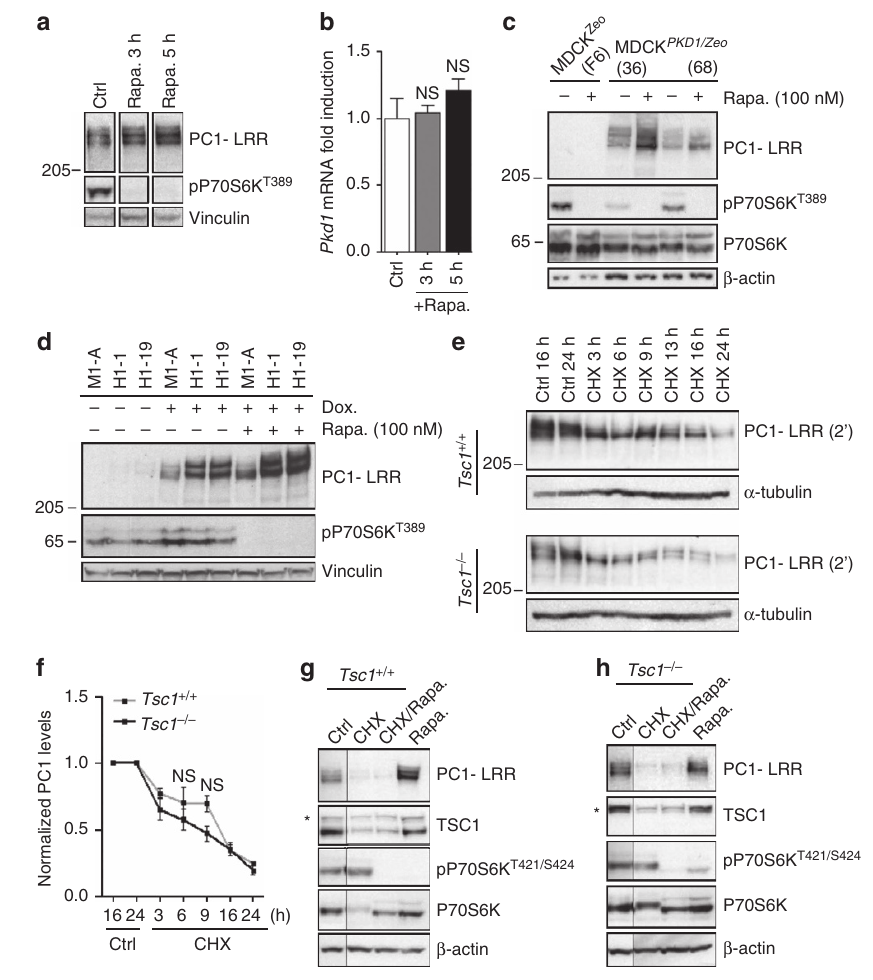
Figure 3 | mTORC1 regulation of polycystin-1 requires protein neo-synthesis. ( a ) Immunoblot shows increased PC1-LRR levels in Pkd1 Myc/Myc MEFs treated with 100nM rapamycin for 3 and 5h. Data are representative of two independent experiments. ( b ) qRT-PCR for Pkd1 gene, nomalized towards Arbp , performed on mRNA extracted from cells in a . Data are shown as mean ± s.d. ANOVA statistical analysis (NS, non significant) followed by Dunnett’s multiple comparison test was performed. NS, non significant. ( c ) Western blot analysis in MDCK Zeo (clone F2, F6) and PKD1 overexpressing MDCK PKD1/ Zeo (clones G7/36, C8/68 and G3) cells shows PC-1 expression after 100nM rapamycin for 24h. Data are representative of two independent experiments. ( d ) Immunoblot showing PC1 levels in doxycicline-inducible MDCK cell line overexpressing the murine Pkd1 (M1-A) and the human PKD1 gene (H1-1, H1-19). Cells were treated 24h with or without 100nM rapamycin. ( e ) Time course analysis of PC-1 levels after protein neo-synthesis inhibition using 50 m M cycloheximide (CHX) in Tsc1 þ / þ and Tsc1 (cid:2) / (cid:2) . ( f ) Graph shows quantification of three independent experiments. Data are shown as mean ± s.e.m. ANOVA statistical analysis NS, non significant. ( g , h ) Treatment of Tsc1 þ / þ ( g ) and Tsc1 (cid:2) / (cid:2) ( h ) MEFs in the presence of cycloheximide prevents the rapamycin ability to upregulate PC-1 levels. Data are representative of three independent experiments. Control lanes were run in the same blot and middle lanes were cut-out (Supplementary Fig. 7). *shows a non-specific band. ANOVA, analysis of